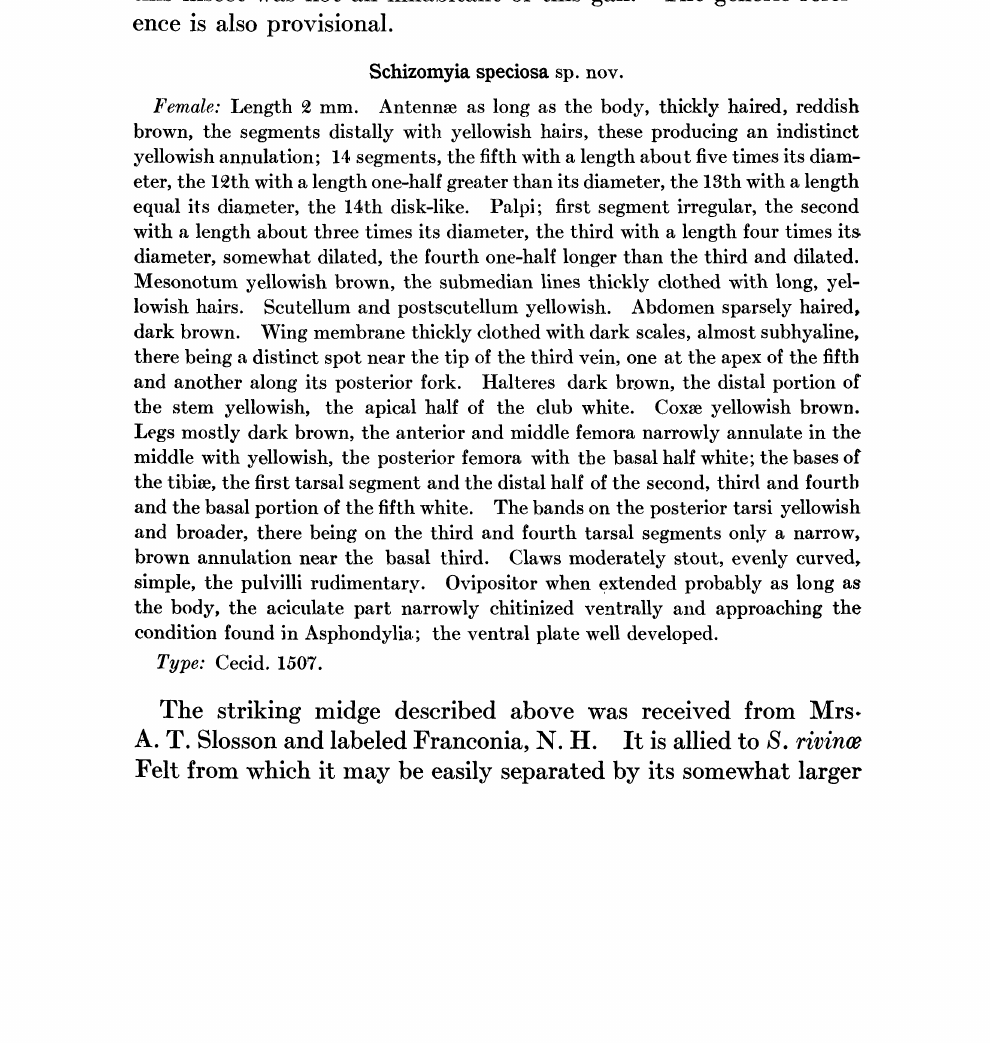
fourth, each as long as the second and successively more slender. Face pale yel- lowish; eyes black. Body yellowish. Mesonotum fuscous, the submedian lines with broad, rather coarse scalelike hairs. Abdomen clothed with fuscous scales and a few long hairs, the incisures yellowish. Wings hyaline, the membrane with numerous narrow, curved scales; costa dark brown. Halteres black. Coxe yel- l.wish; femora basally pale yellowish, the tibiae and tarsi gradually darker to dark brown. Claws slender, strongly curved, unidentate, the pulvilli about half the. length of the claws. Ovipositor short, the lobes narrowly oval and thickly setose. Type: Cecid.